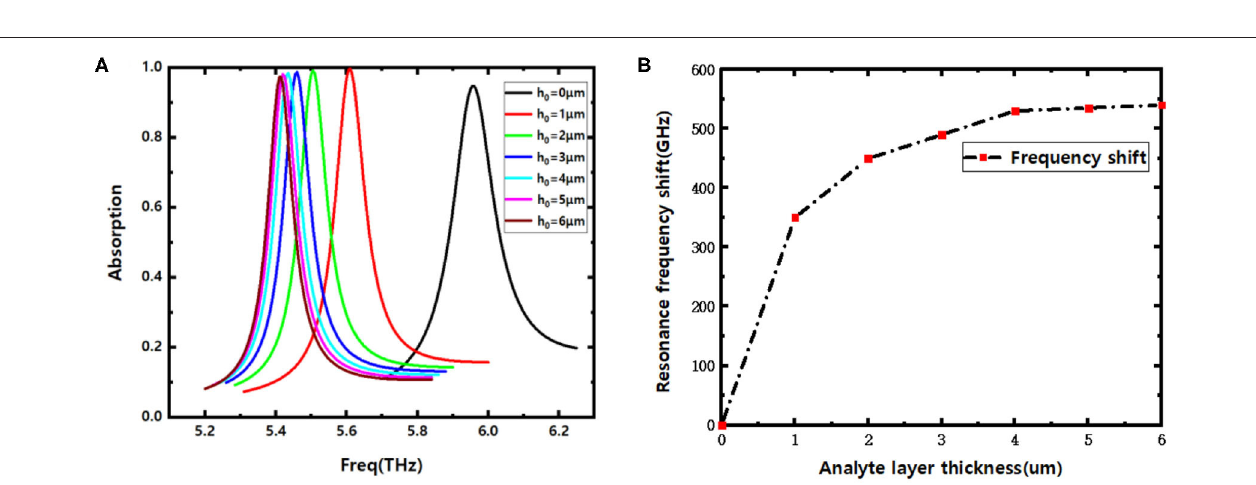
FIGURE 5 | (A) Absorption curves for different analyte thickness h 0 ; (B) resonance frequency shifts with increasing analyte thickness h 0 .